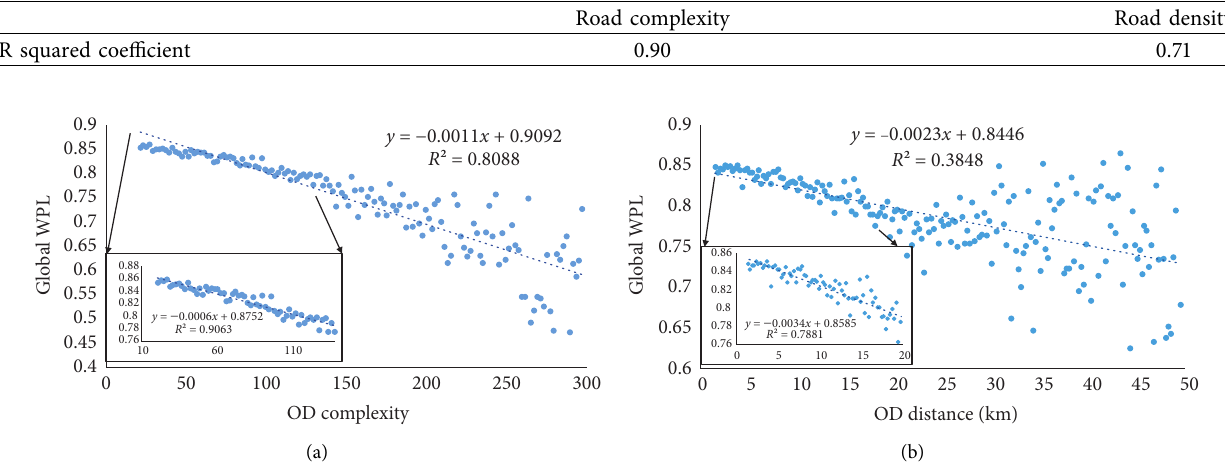
Figure 13: Correlation analysis of OD features and WPL: (a) path complexity; (b) path